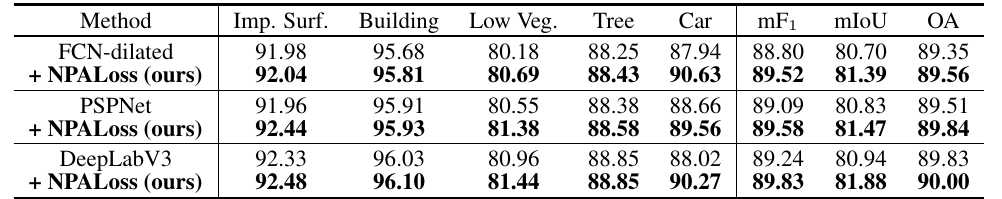
Table 3. The performance of our proposed NPALoss on different segmentation networks.